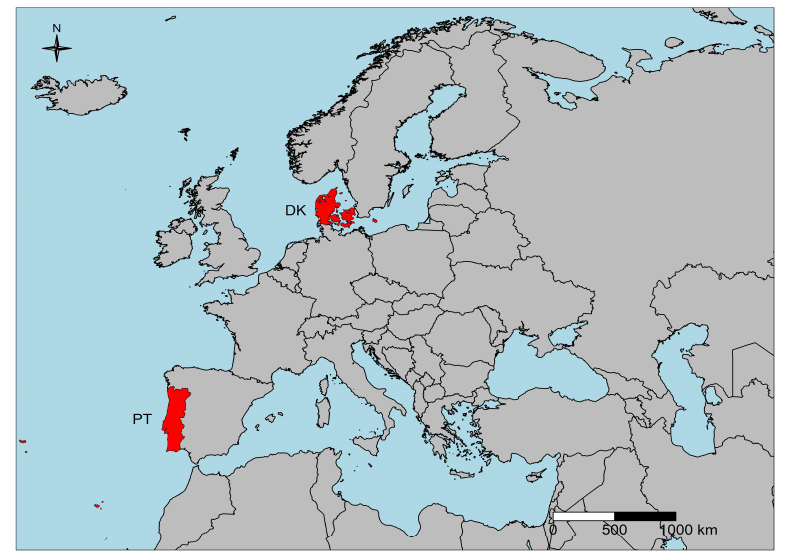
Figure 1. Location of Portugal (PT) and Denmark (DK) in Europe.